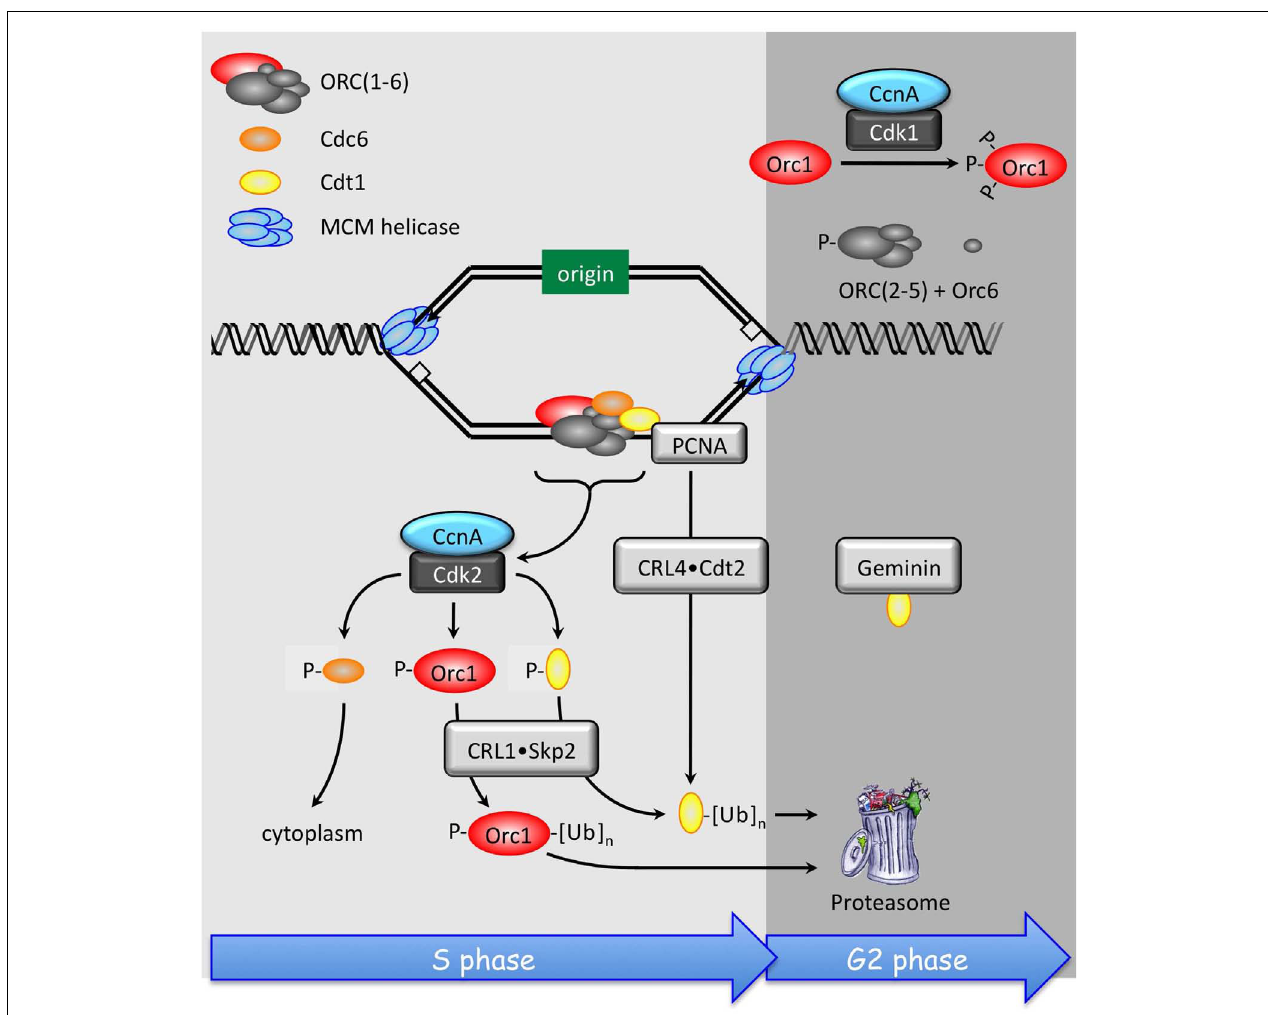
phosphorylated, but associated with PCNA and DNA, is targeted for degradation by the CRL4 • Cdt2 ubiquitin ligase. PCNA is the eukaryotic sliding clamp protein that allows DNA polymerases- δ and - γ to synthesize DNA continuously without falling off the primer–template. Binding of Geminin also inhibits Cdt1, and Orc1 is also inhibited directly by Cdk1 • CcnA phosphorylation, events that are required during G2 and early M